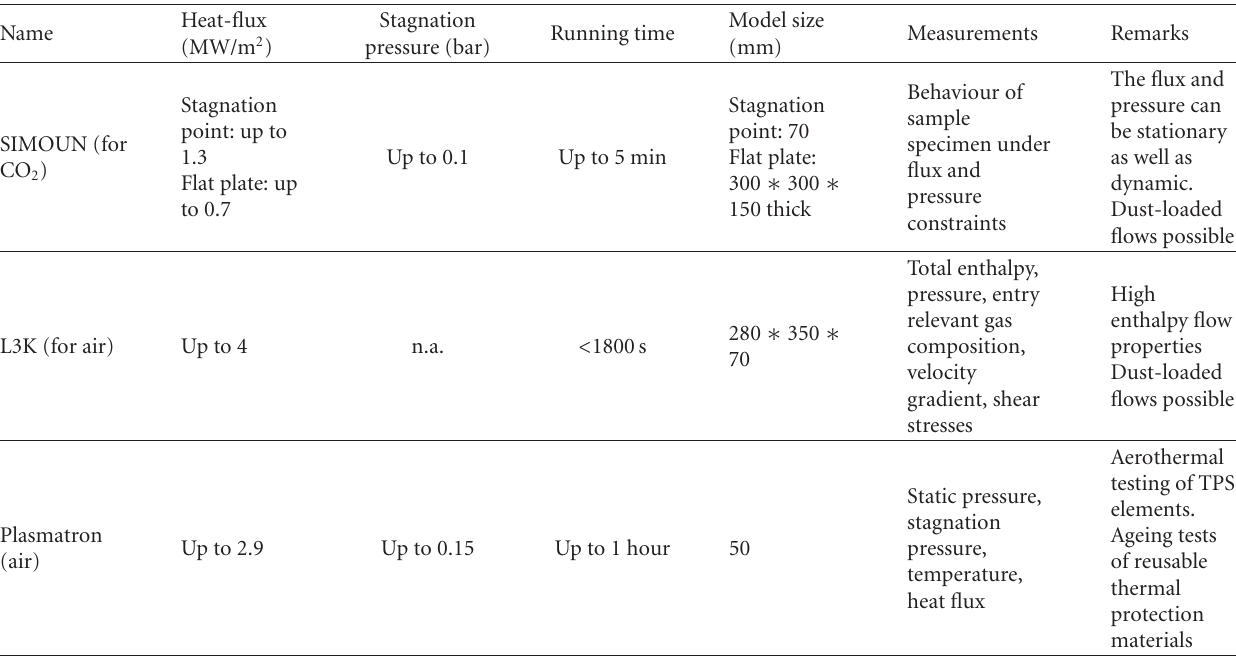
Table 3: Characteristics of European facilities for TPS